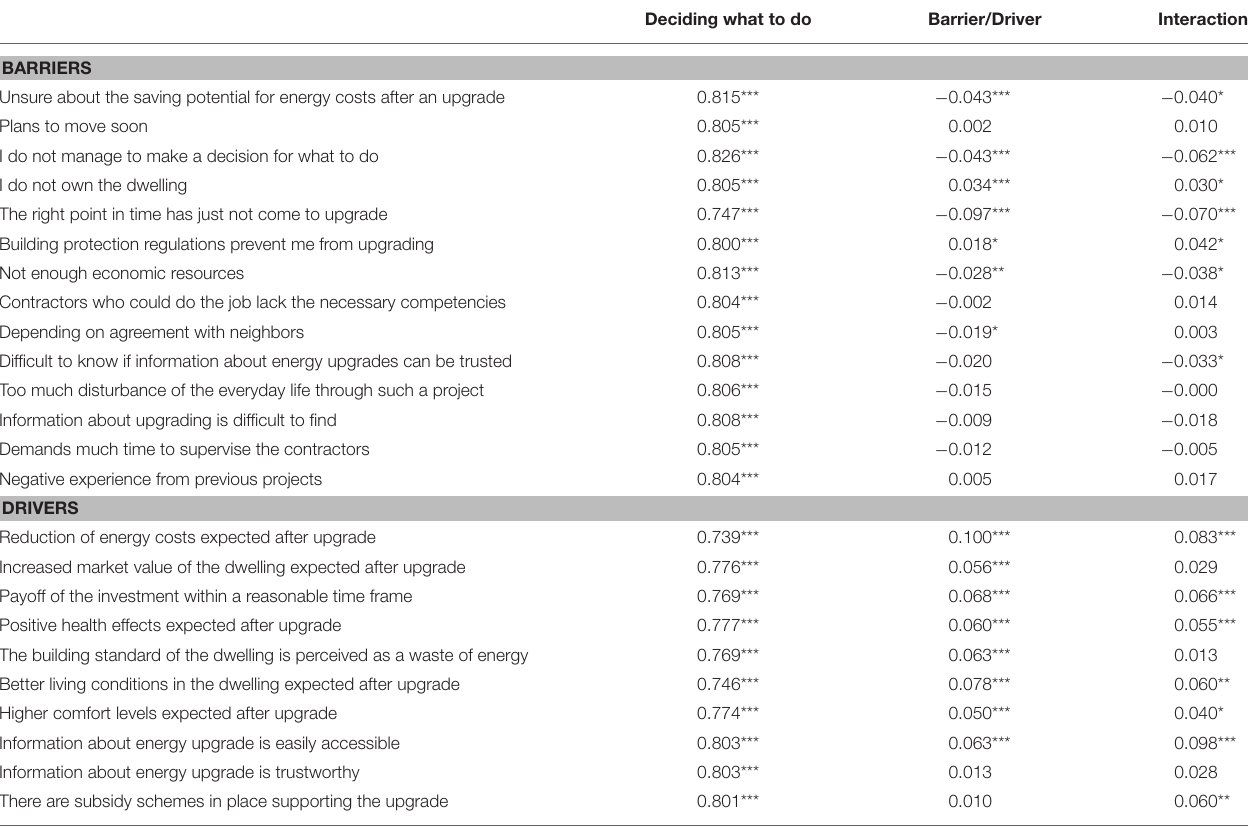
TABLE 4 | Analysis of the moderating effects of barriers and drivers on the transition from deciding what to do to deciding how to do it ( N = 3.787). Deciding what to do Barrier/Driver Interaction